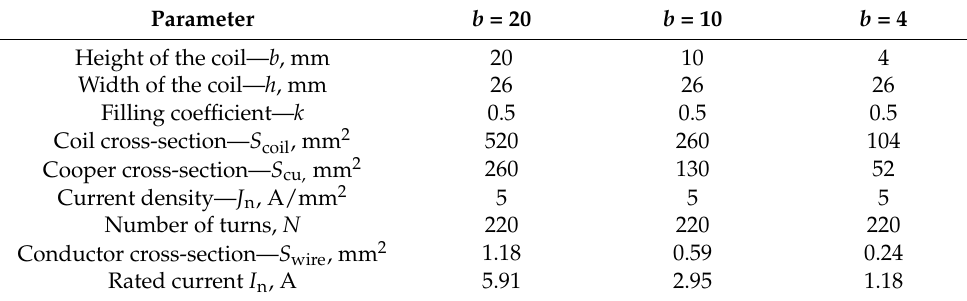
Table 3. Winding parameters of the TFM with an outer and inner rotor.